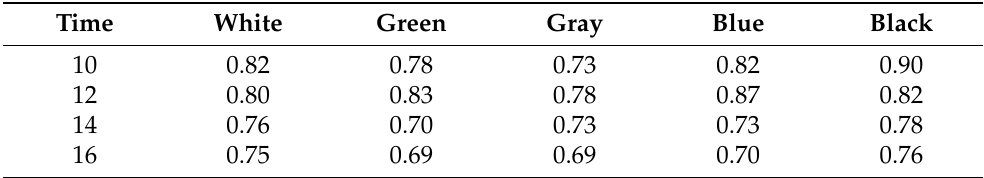
Table 6. Correlation index between the surface temperature and room temperature through the Pearson’s correlation